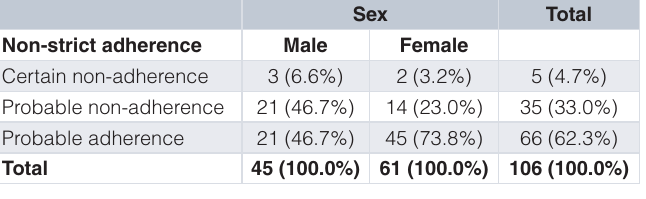
Table 7. Univariate analysis of sex and non-strict adherence (all categories), Pearson χ 2 = 8.10, P = 0.017 (Fishers exact P = 0.013). Sex Total Non-strict adherence Male Female Certain non-adherence